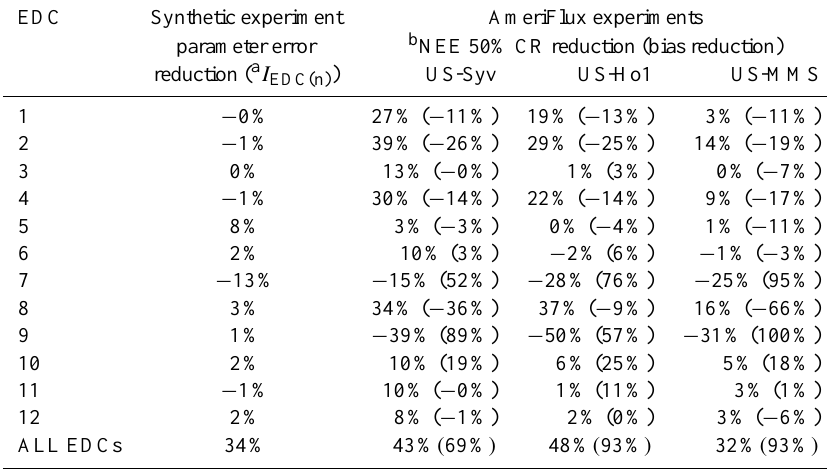
Table 2. Synthetic experiment parameter error reduction, and AmeriFlux experiment 3 yr NEE 50% CR and bias reduction for MDF estimates using individual EDCs, relative to the standard MDF estimates.